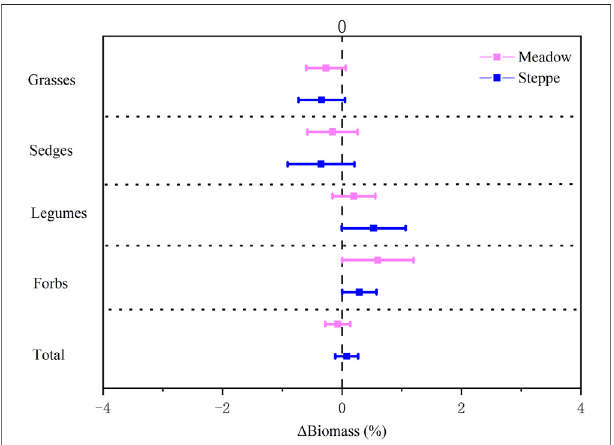
FIGURE 4 | Change in grass, sedge, legume, forb, and total plant cover in alpine meadow (red) and steppe (blue) from 2008 to 2018 in the permafrost region of the Tibetan Plateau. The relative change rate in cover ( Δ Cover, %) was calculated as the ratio of the absolute change (in units of %) to the mean cover value over the study period. Data were shown as estimate ±95% con fi dence intervals (CI). Data greater than zero represent a signi fi cant increase in the measured variable, and data lower than zero represent a signi fi cant decrease between 2008 and 2018.